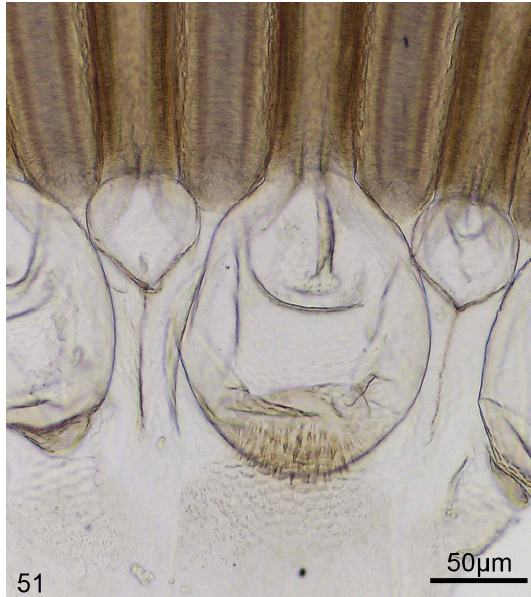
Fig 51. Mapinguaritermes sp., ornamentation of spines at the base of the first-order pulvillus of the gizzard.